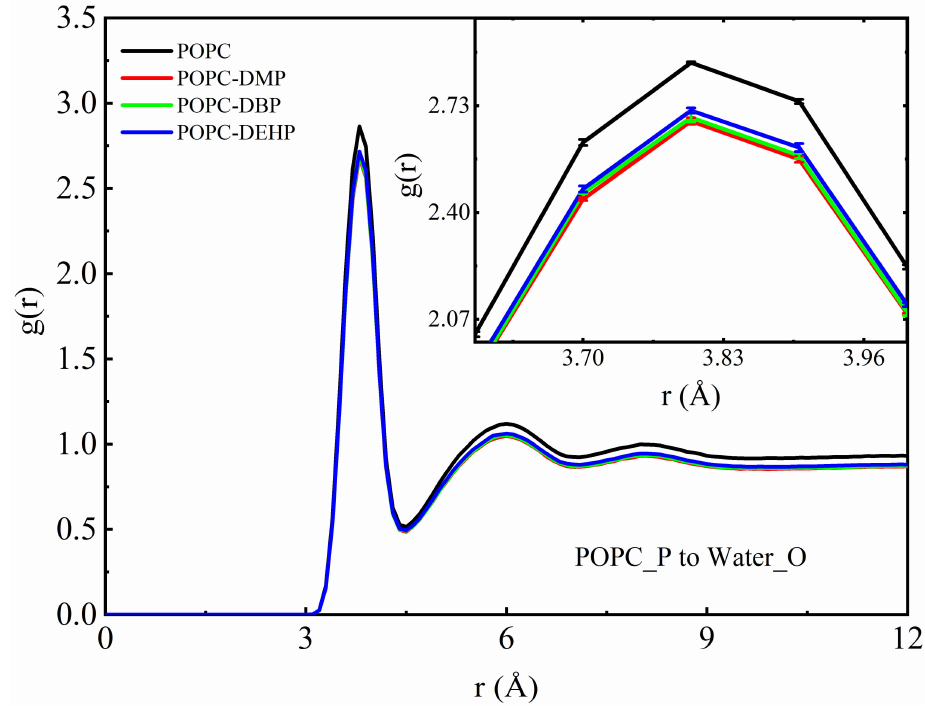
Figure 7. Radial distribution function plot of water oxygen to phosphorus atom of POPC lipid bilayers. The inset shows the amplified decrease in density caused by the addition of PAEs